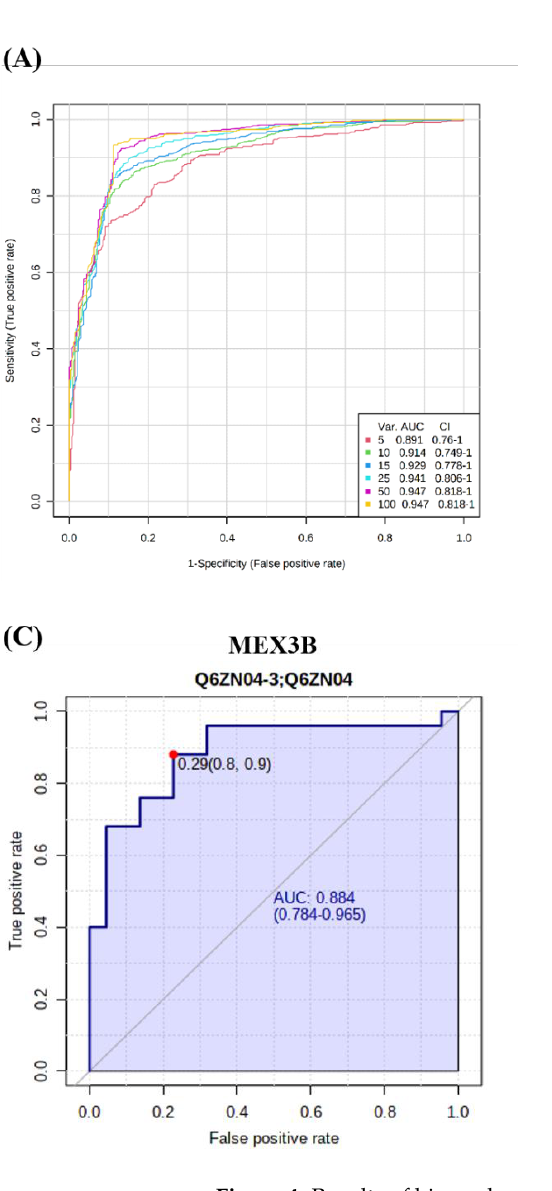
Figure 4. Results of biomarker evaluation in ON and OP. ( A ) Exploratory ROC curve generated by the OPLS-DA model; AUC values were calculated by mathematical integration of the combination of 5, 10, 15, 25, 50, and 100 proteins. ( B – D ) Three proteins with the highest AUC: ( B ) IGLC1, AUC = 0.929; ( C ) MEX3B, AUC = 0.884; and ( D ) FBLNI, AUC =